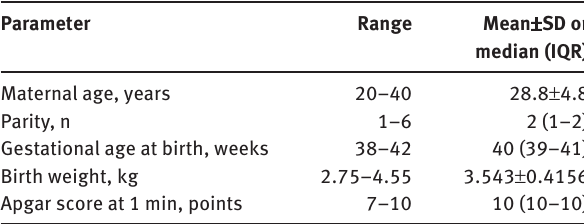
Table 1: Characteristics of the studied group.